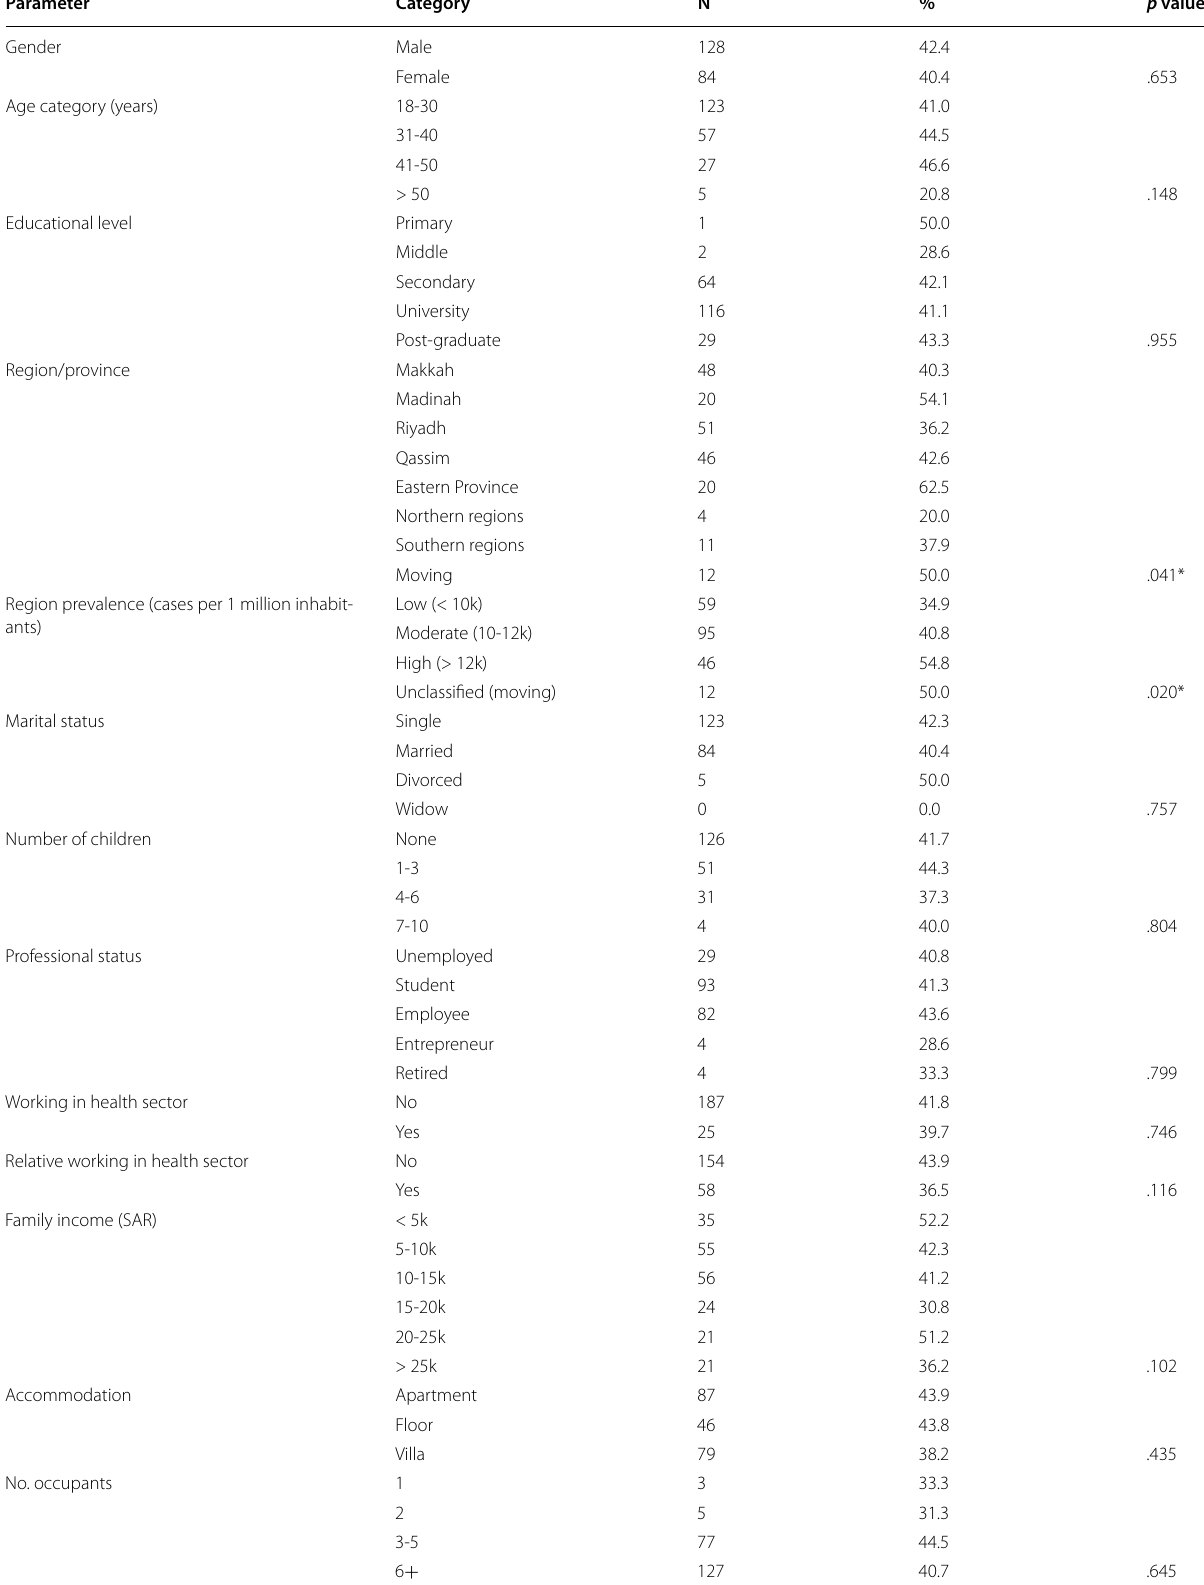
Table 5 Sociodemographic factors associated with PTSD post COVID-19 lockdown